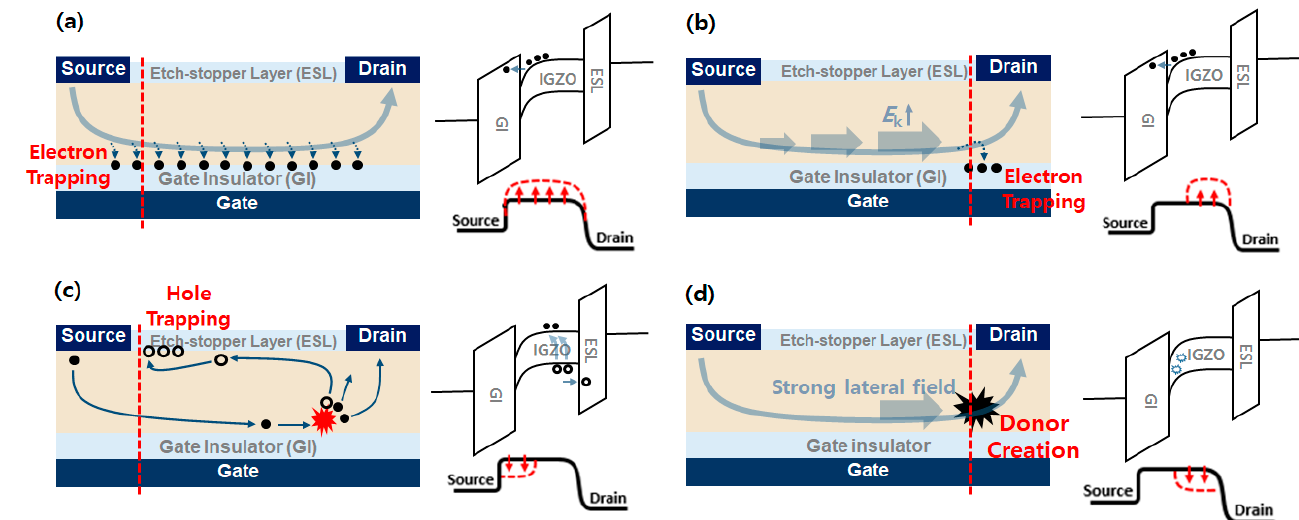
Figure 3. Schematic structures and energy band diagrams of four different mechanisms of V T shift in IGZO TFT device: ( a ) Electron trapping at the GI layer by vertical electric field; ( b ) Electron trapping at the drain-side GI layer by HCI; ( c ) Hole trapping at the source-side ESL by impact ionization; ( d ) Donor-like state creation in the drain-side IGZO layer by lateral electric field.